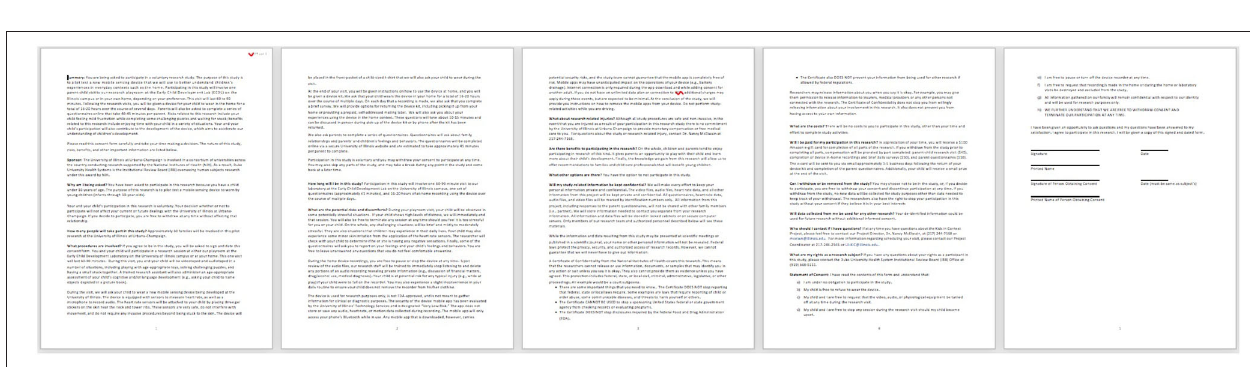
FIGURE 5 | Original IRB approved consent form approved by an